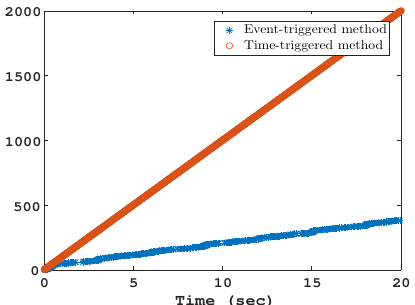
Figure 9. The numbers of time-triggered and event-triggered methods.